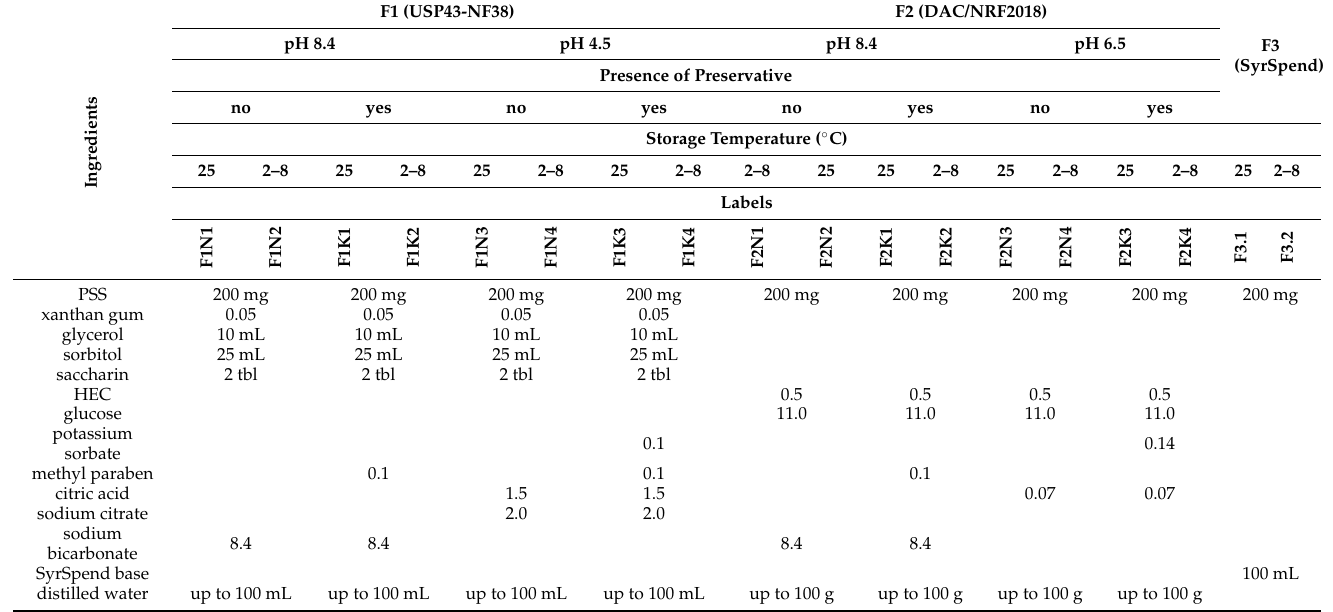
Table 1. Compositions of prepared sample suspensions with pantoprazole (2mg/mL) and different syrup